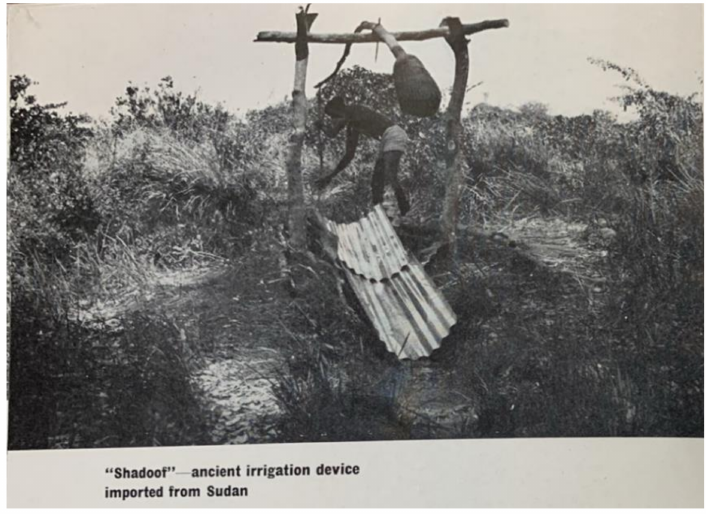
Figure 1. A shadoof